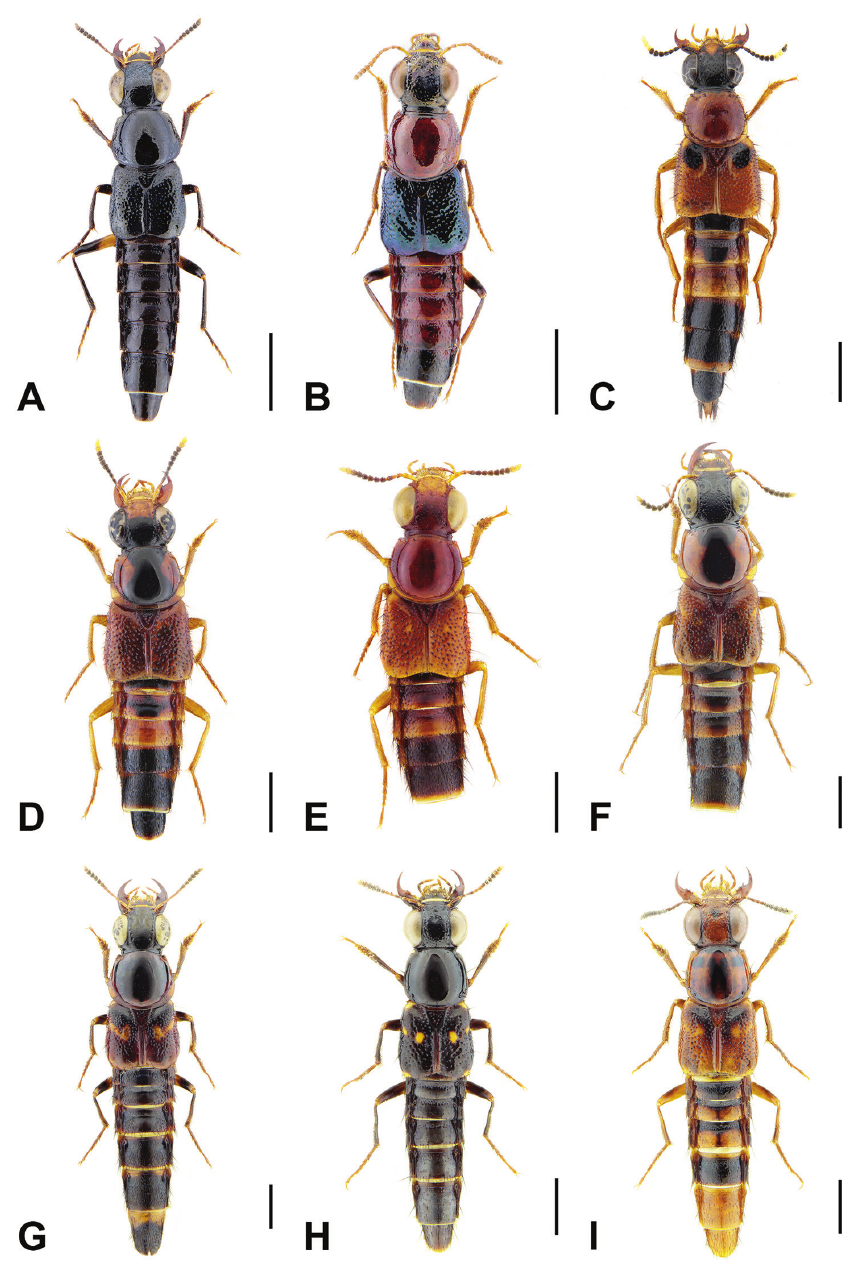
Figure 1. Dorsal habitus of Bolitogyrus electus Smetana & Zheng ( A ), B. kitawakii (Smetana & Zheng) ( B ), B. caesareus (Bernhauer) ( C ), B. proximus (Cameron) ( D ), B. rufipennis (Cameron) ( E ), B. pederseni Brunke ( F ), B. nokrek Brunke ( G ), B. lasti Rougemont ( H ) and B. tigris Brunke ( I ). Scale bars: 2